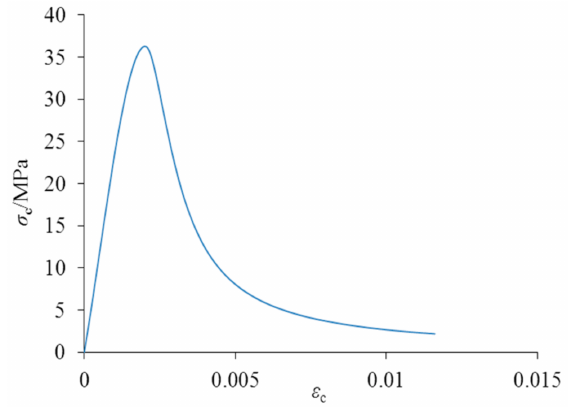
Figure 13. Compression stress-strain curve of recycled